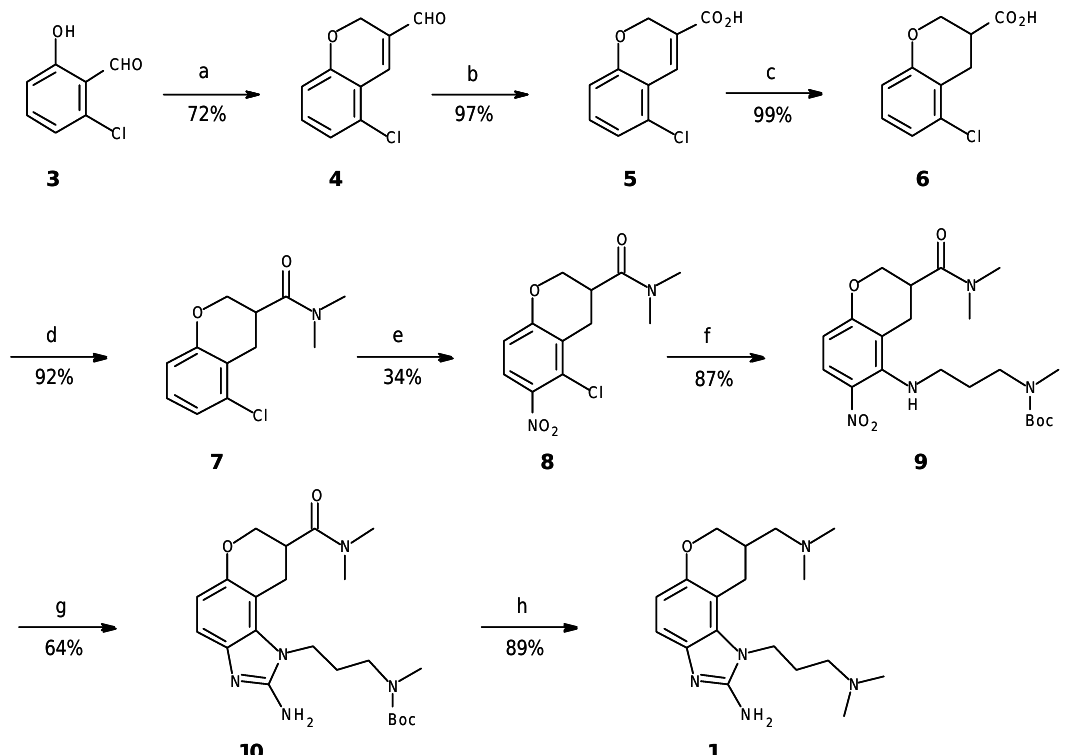
Scheme 1. New route to dihydropyranobenzimidazole